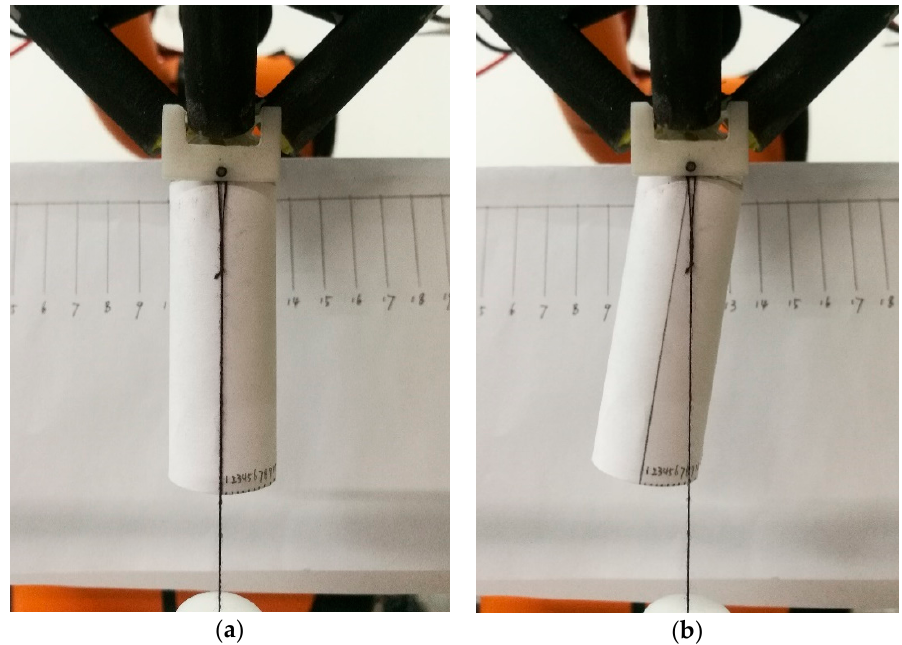
Figure 12. The deflection motion of the rotor. ( a ) shows the initial position of the rotor, and ( b ) exhibits the deflection motion of the rotor. In above figure, a rotary pair is utilized to equip the plumb and constrain the rotational motion of the rotor.